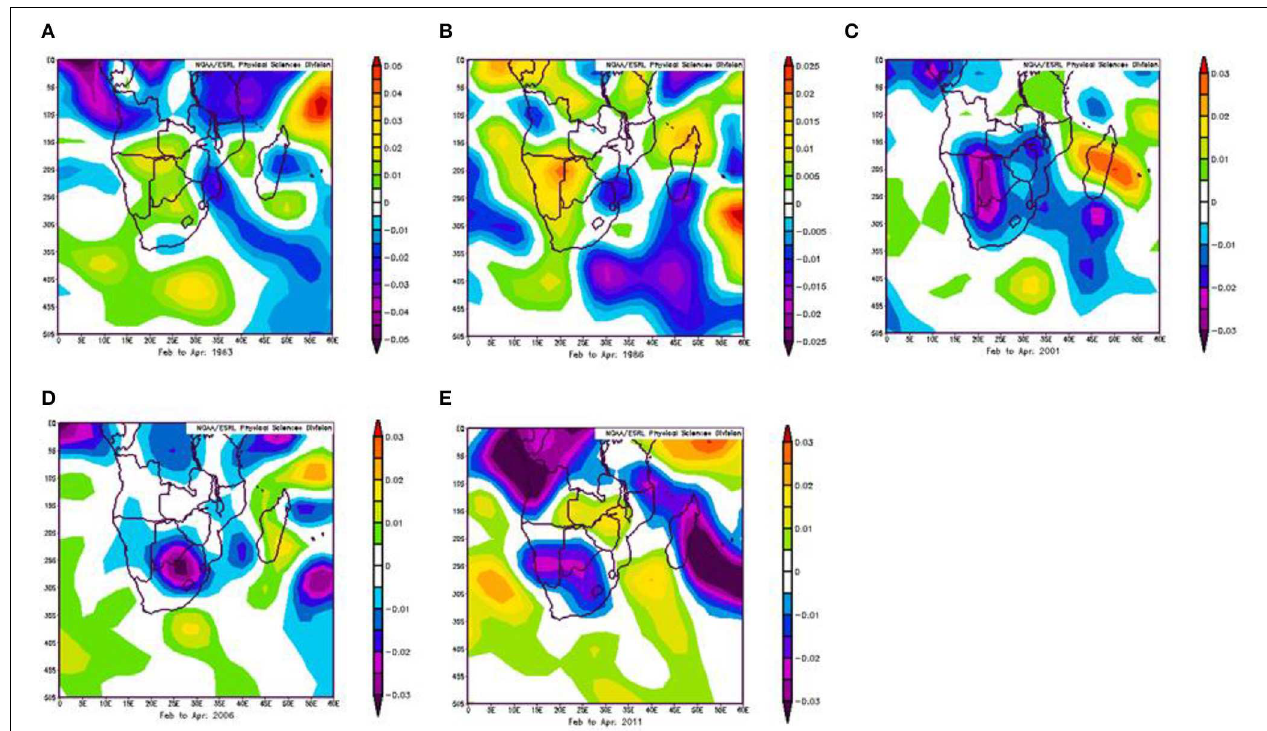
FIGURE 8 | FMA omega (pressure tendency) at the 500 hPa level for (A) 1963, (B) 1986, (C) 2001, (D) 2006, and (E) 2011. Contour interval is 0.005 Pas − 1